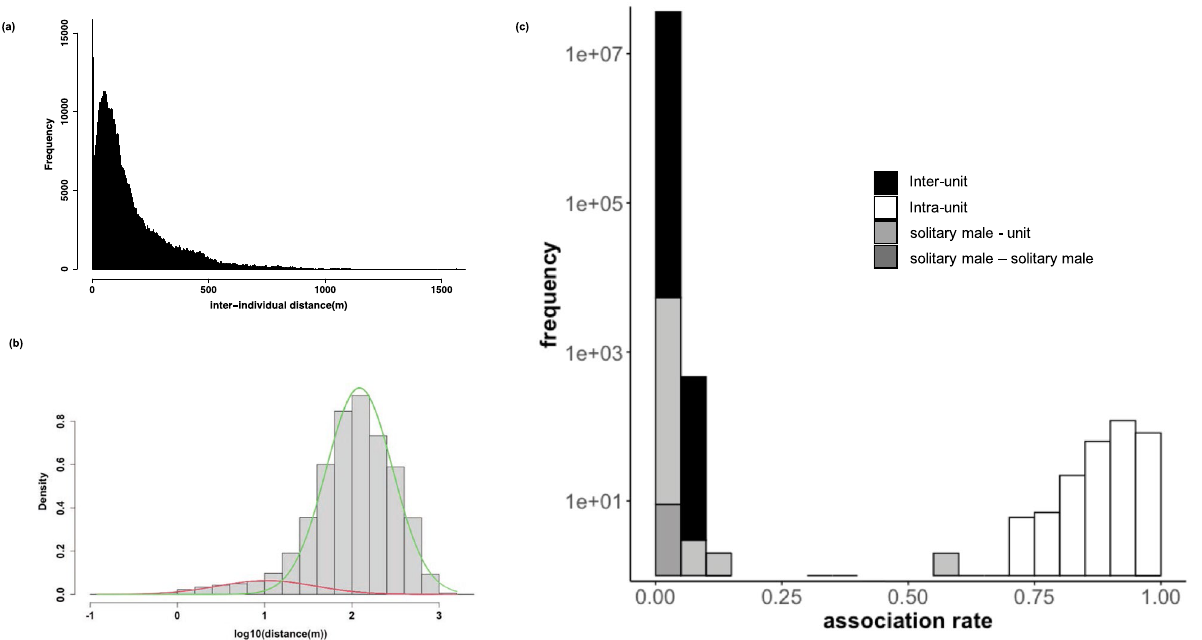
Figure 2. ( a ) Histogram of inter-individual distances showing clear bimodality. ( b ) The inter-individual distance was converted to logarithmic scale and then fitted to Gaussian mixture model. The green and the red lines represent the two estimated Gaussian distributions. ( c ) The unit-level association rate also showed bimodal structure. We later examined the histogram of ( c ) to investigate how the association pattern was distributed according to the individual’s belonging. The y axis of ( c ) is on a logarithmic scale. The graphs were created using the statistical software R 49